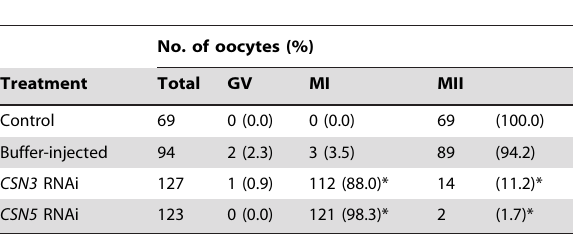
Table 2. in vitro maturation of mouse oocytes after CSN3 or CSN5